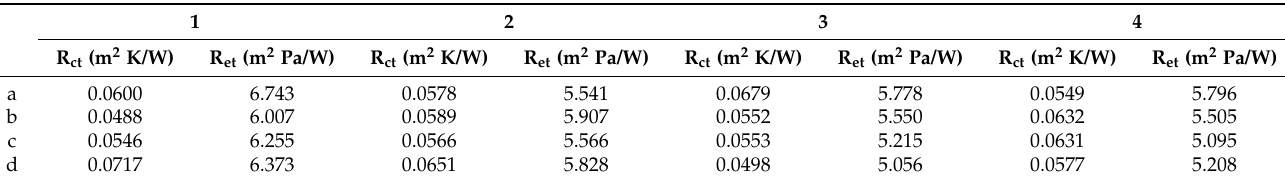
Table 5. Thermal resistance (R ct ) and water-vapour resistance (R et